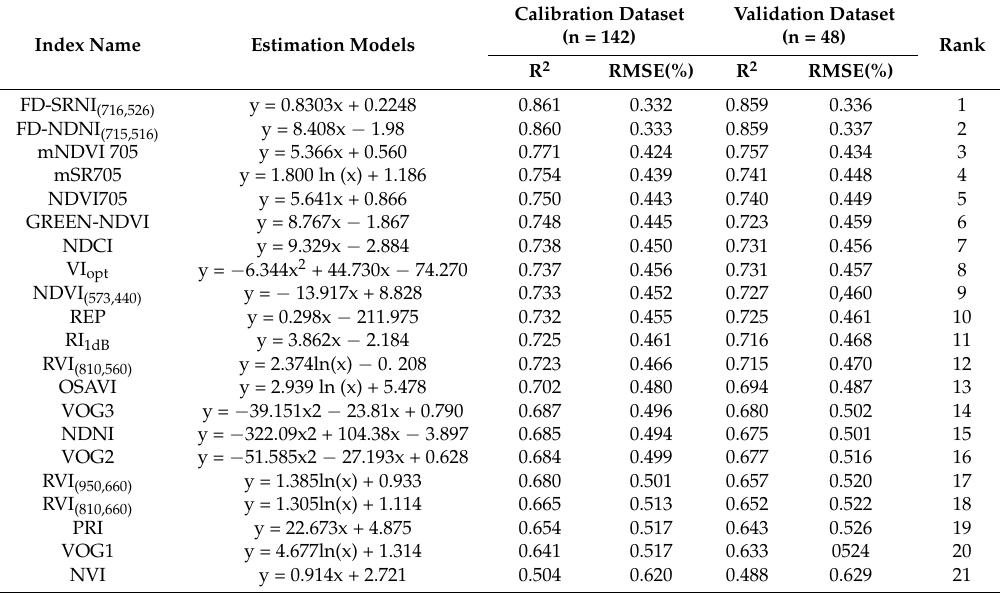
Table 3. Estimation models and evaluation indicators based on various spectral indices (n =